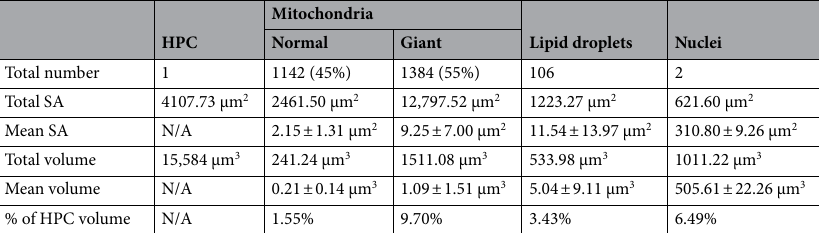
Table 1. A comparative summary of quantitative volumetric data, extending the image data for the selected hepatic parenchymal cell depicted under Fig. 3. HPC, Hepatic parenchymal cell; SA, surface area. Results are expressed as means ± S.D where